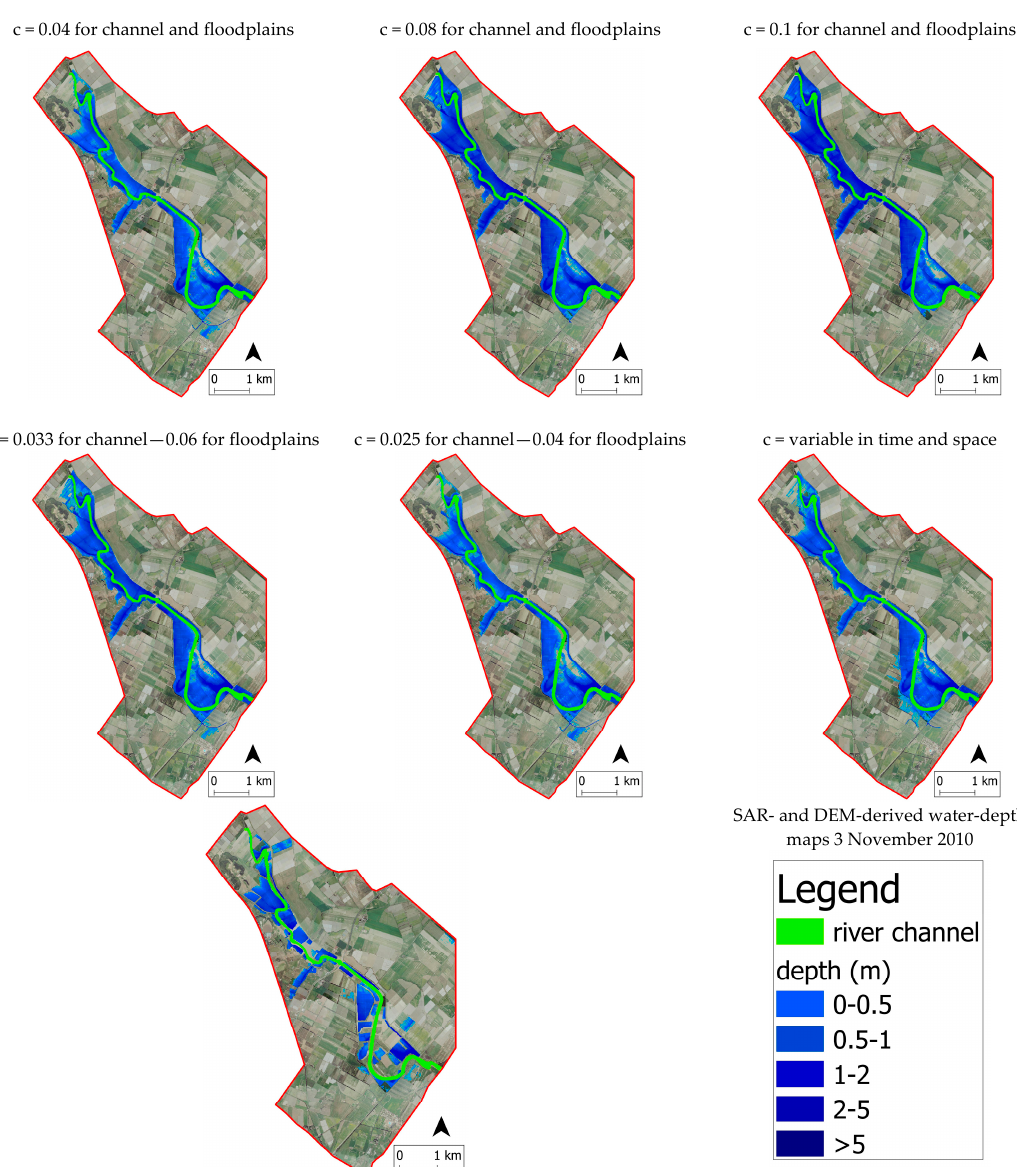
Figure 4. Comparison between the 6 hydrodynamic simulations characterized by a different set of Manning coefficient values and the SAR- and DEM-derived water-depth map for 3 November 2010.